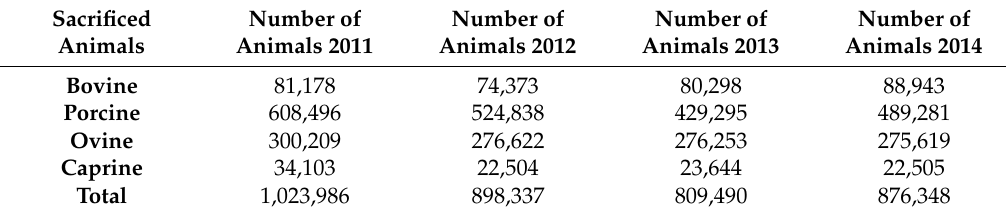
Table 4. Number of sacrificed animals in 2011, 2012, 2013 and 2014 in Extremadura (Spain) [1].